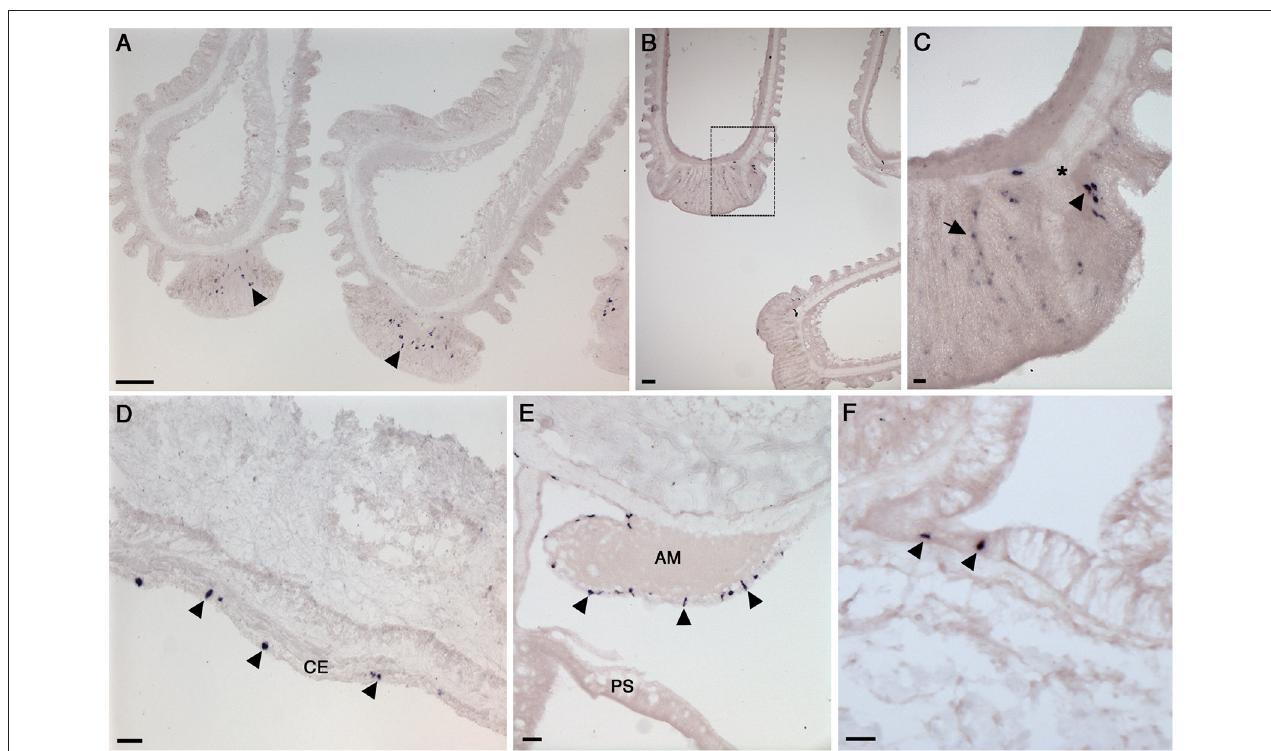
FIGURE 6 | Localization of NGFFYamide precursor mRNA expression in the tube feet, apical muscle and body wall of A. rubens . (A) Longitudinal sections of two tube feet, showing stained cells (arrowheads) in the sucker region. (B) Longitudinal sections of three tube feet, with the boxed region shown at higher magnification in (C) ; here stained cells (arrowhead) can be seen near to the basal nerve ring (*) and in the adhesive region of the tube foot sucker (arrow). (D) Transverse section of an arm showing stained cells (arrowheads) in the coelomic epithelium. (E) Transverse section at the junction between an arm and the central disk showing stained cells (arrowheads) in the coelomic epithelial lining the apical muscle. (F) Transverse section of an arm showing stained cells (arrowheads) in the external epithelium of the body wall. AM, apical muscle; CE, coelomic epithelium; PS, pyloric stomach. Scale bars: (A) : 33 µ m; (B) : 33 µ m; (C) : 6 µ m; (D) : 16 µ m; (E) : 16 µ m; (F) : 16 µ m.